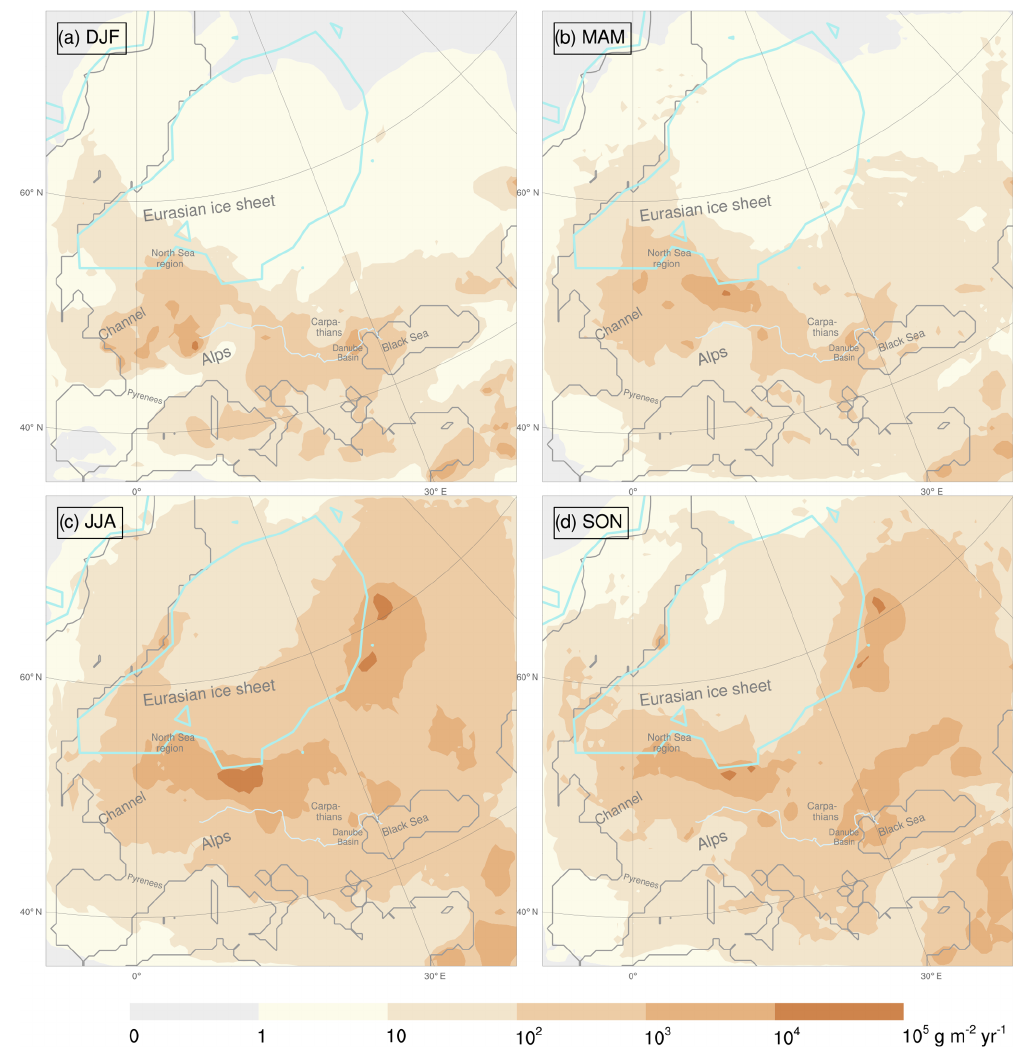
Figure 6. Dust deposition rates for (a) winter (DJF), (b) spring (MAM), (c) summer (JJA), and (d) autumn (SON) during the Last Glacial Maximum. This reconstruction is based on dynamic downscaling. Ice sheet extents (turquoise; Cline et al., 1984), Danube (light-blue line), and coastlines (grey; Braconnot et al., 2012) are